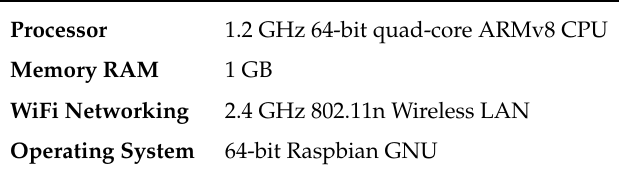
Table 4. Raspberry Pi 3 Model B specifications.